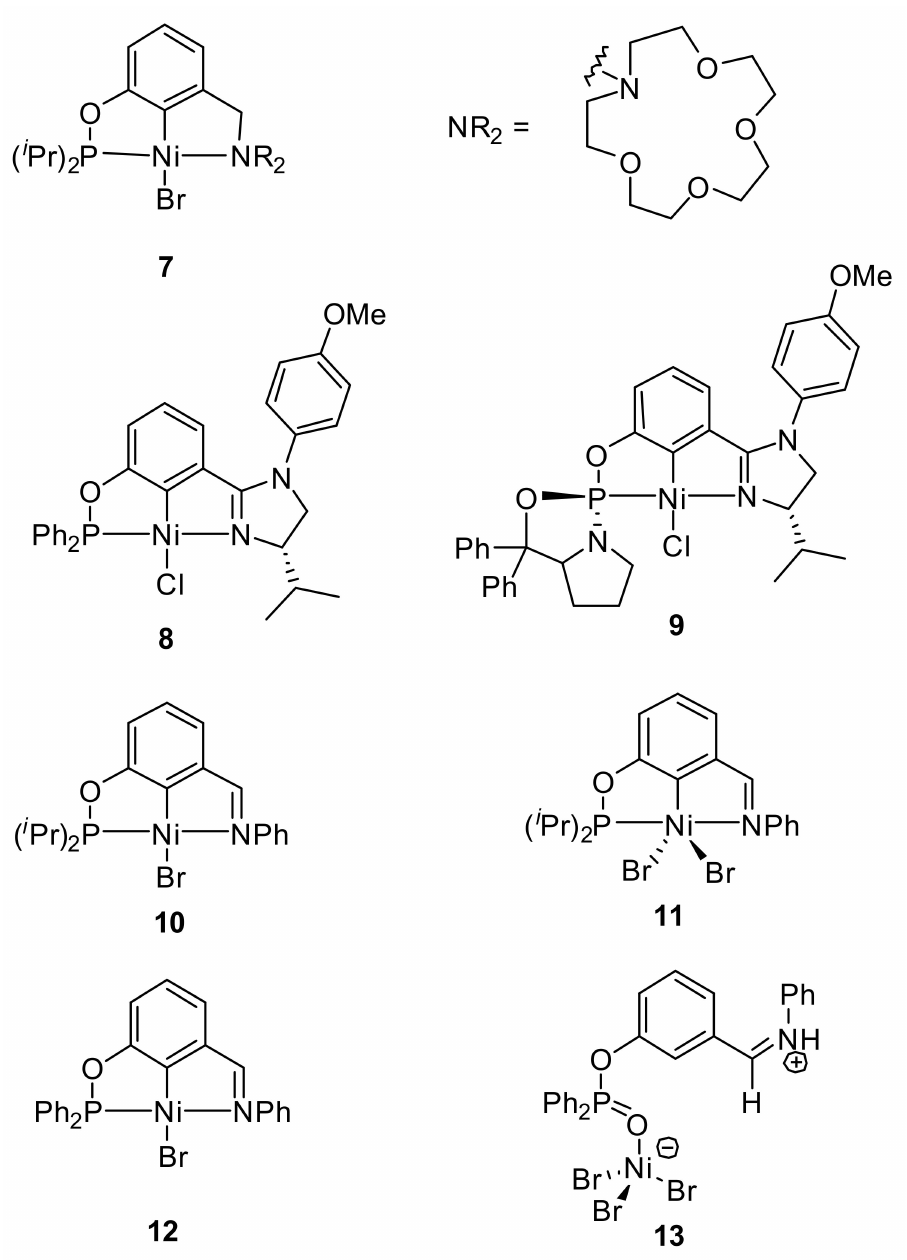
Figure 4. Structure of unsymmetrical POCN pincer nickel complexes 7 – 13